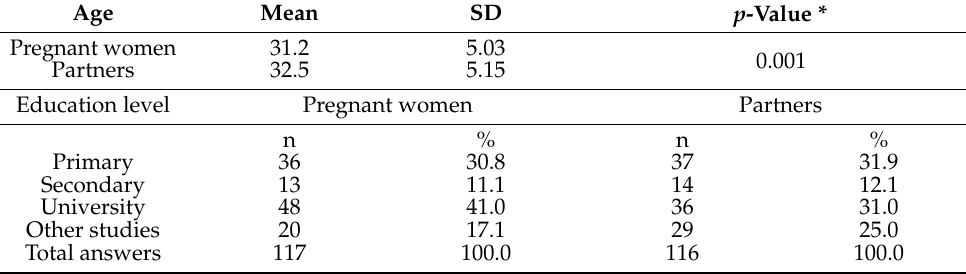
Table 1. Sociodemographic variables of the pregnant women and their partners.